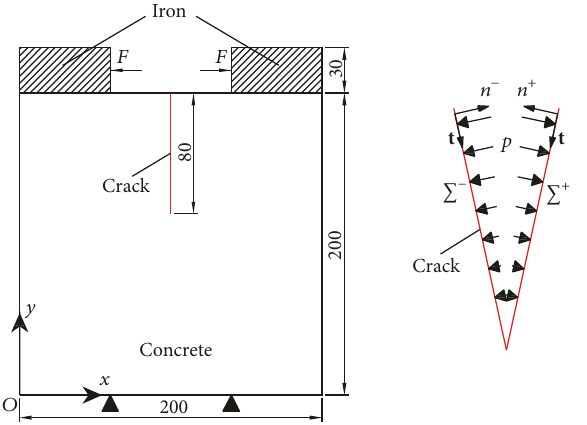
Figure8:Schematicofanotchedcubicconcretespecimensubjected to a splitting force (unit: mm).